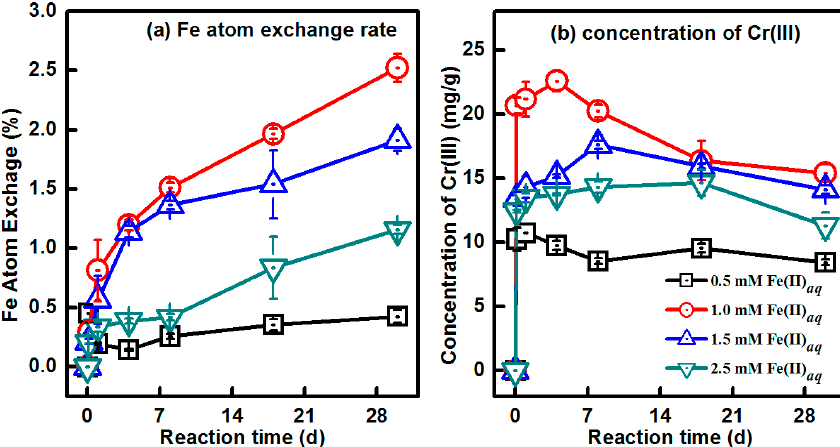
Figure 9. Changes in ( a ) Fe atom exchange percentage and ( b ) Cr(III) extr concentrations during the Fe(II) aq -induced recrystallization of 9.03% Cr-goethite over 30 days with 0.5 mM, 1.0 mM, 1.5 mM, and 2.0 mM of initial Fe(II) aq .